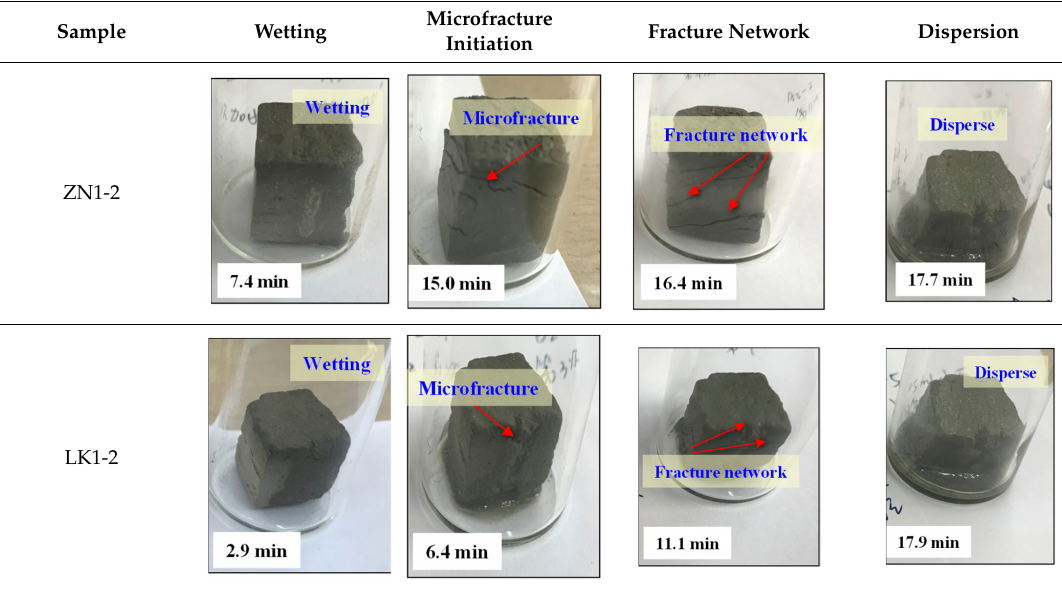
Table 3. Changes of ZN and LK formation sample